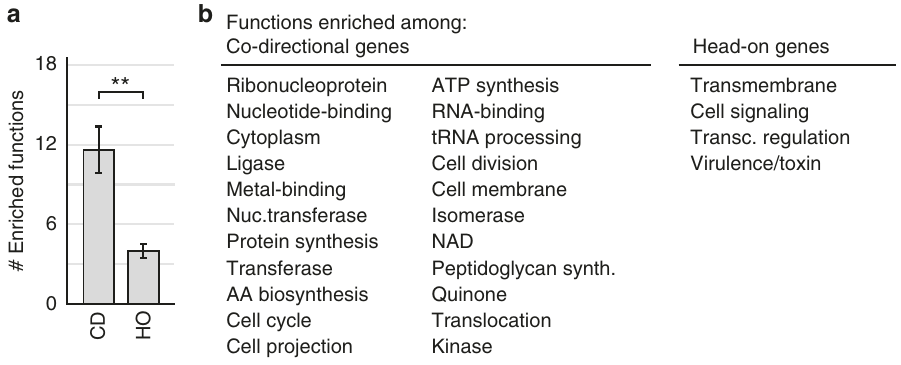
Table 2 HO drug resistance genes evolve at an accelerated rate